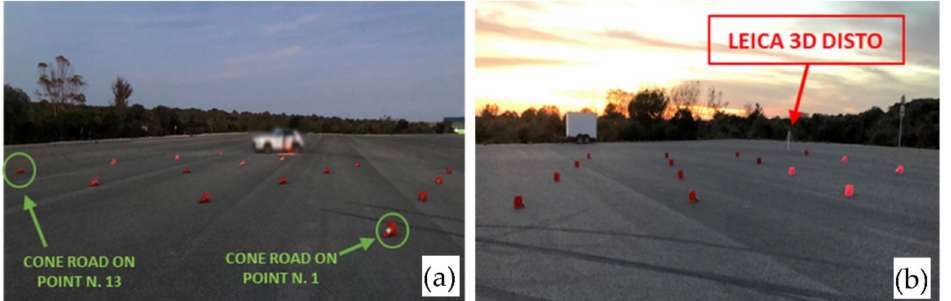
Figure 17. Cones arrangement on the staked-out grid points: points 1 and 13 are indicated to make clear the y -axis direction set on the road ( a ); Leica 3D Disto sensor to measure relative distances ( b ).